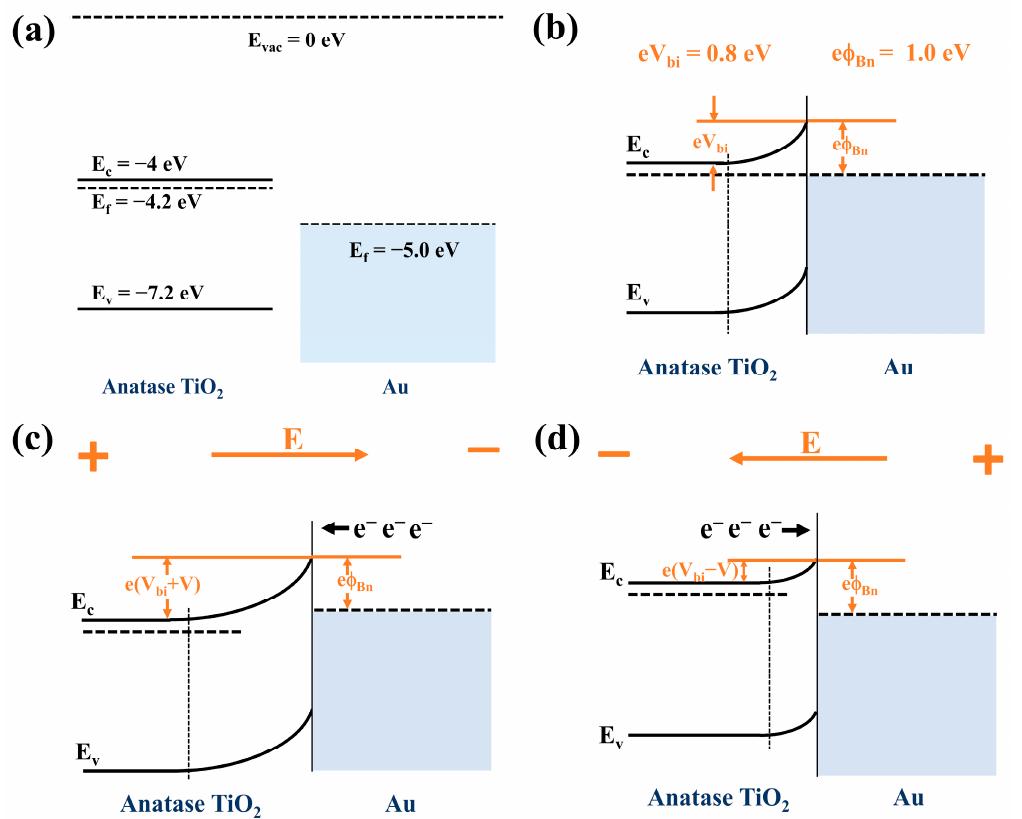
Figure 5. Energy band diagrams for TiO 2 NT@Au NP ( a ) before contact, and ( b ) after contact for thermal equilibrium. ( c ) The positive voltage V is applied to the TiO 2 NT relative to the Au NP, and ( d ) the positive voltage V is applied to Au NP relative to the TiO 2 NT.